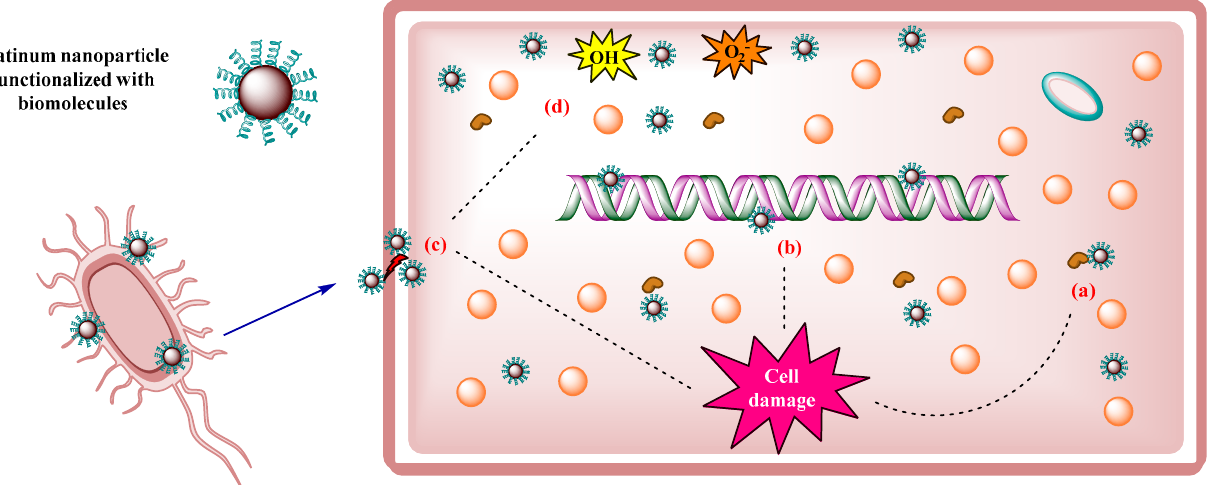
Figure 4. Mechanism of action of PtNPs against bacterial cells. ( a ) Denaturation of essential enzymes. ( b ) DNA damage. ( c ) Cell lysis. ( d ) Production of hydroxyl radicals (OH) and superoxide (O 2 − ).